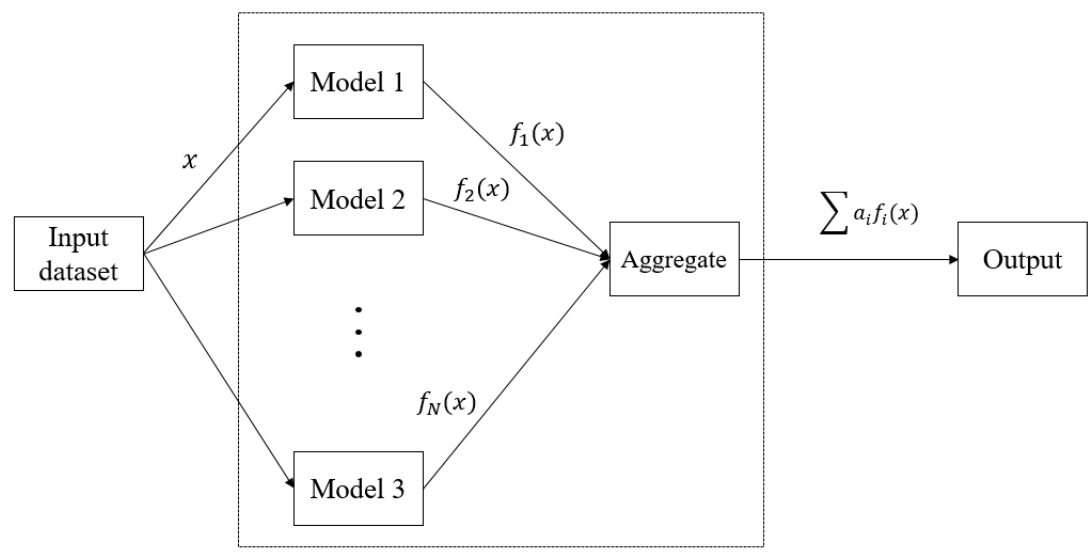
Figure 3. Conceptual diagram of the stacking ensemble learning method.